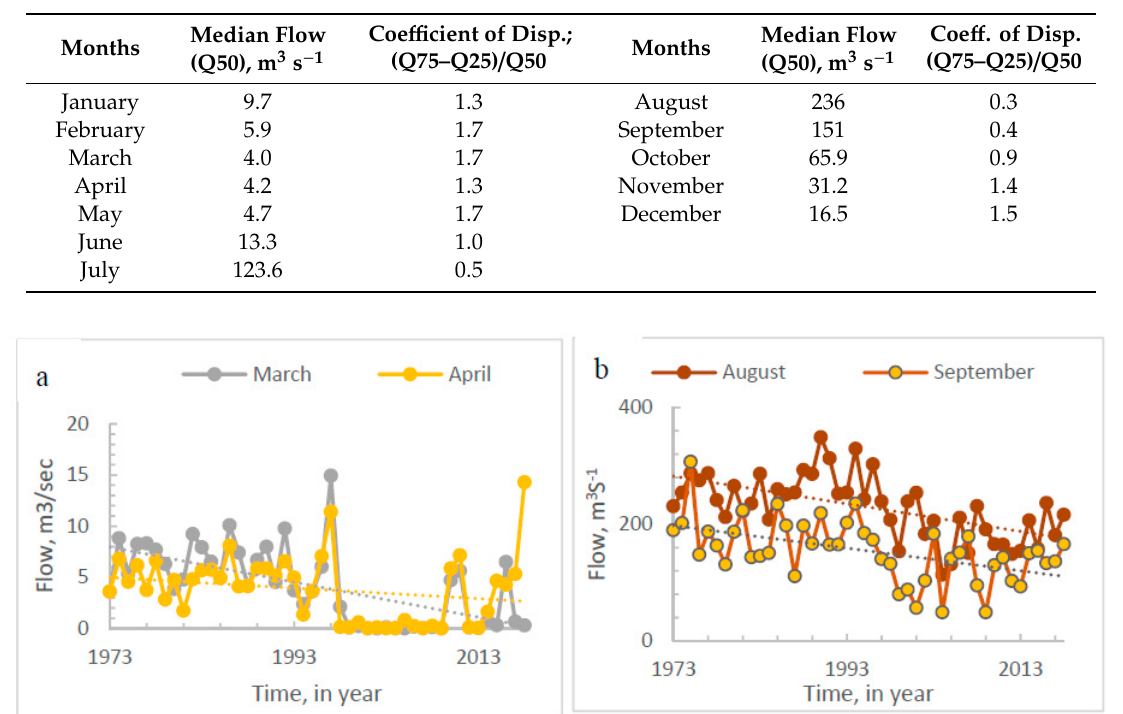
Table 1. Monthly Median Flows (m 3 s − 1 ) of Gumara River at the outlet (1973–2018). See Figure 1 for the location of the outlet; Q25 is flow that is exceeded 25% of the time, Q50 is the median and Q75 is flow exceeded 75% of the time.